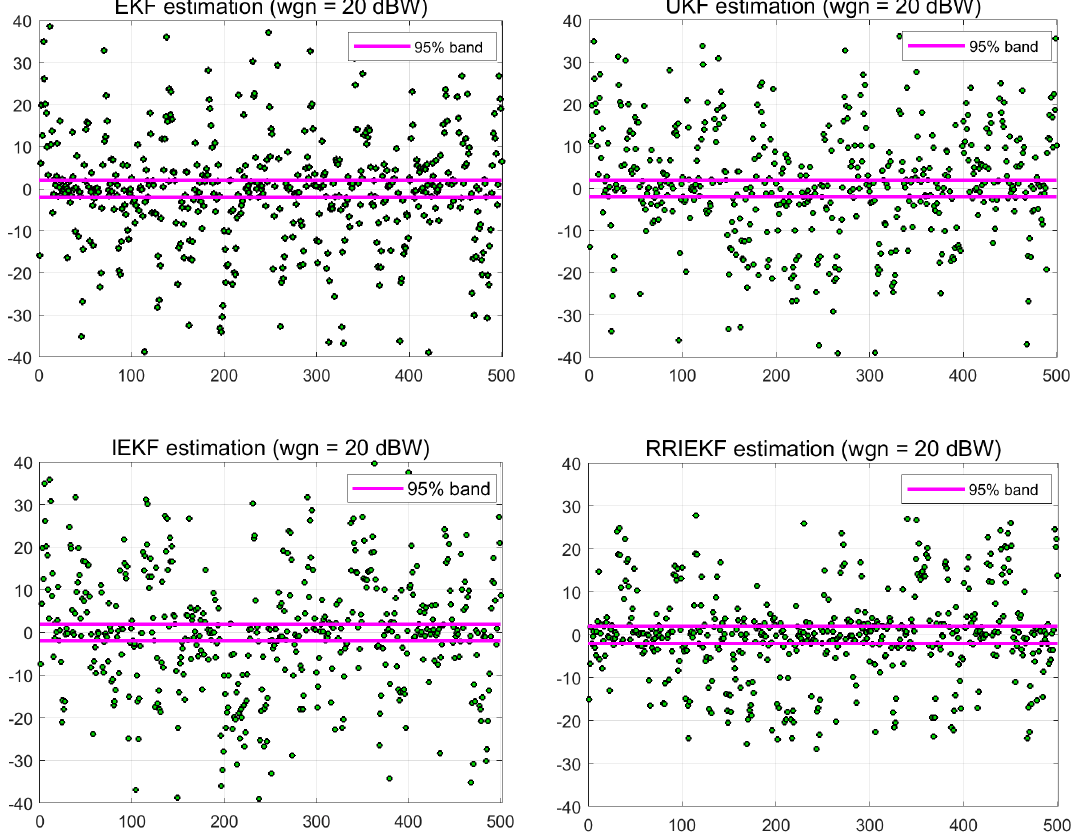
Figure 6. 95% confidence level estimation residual index.